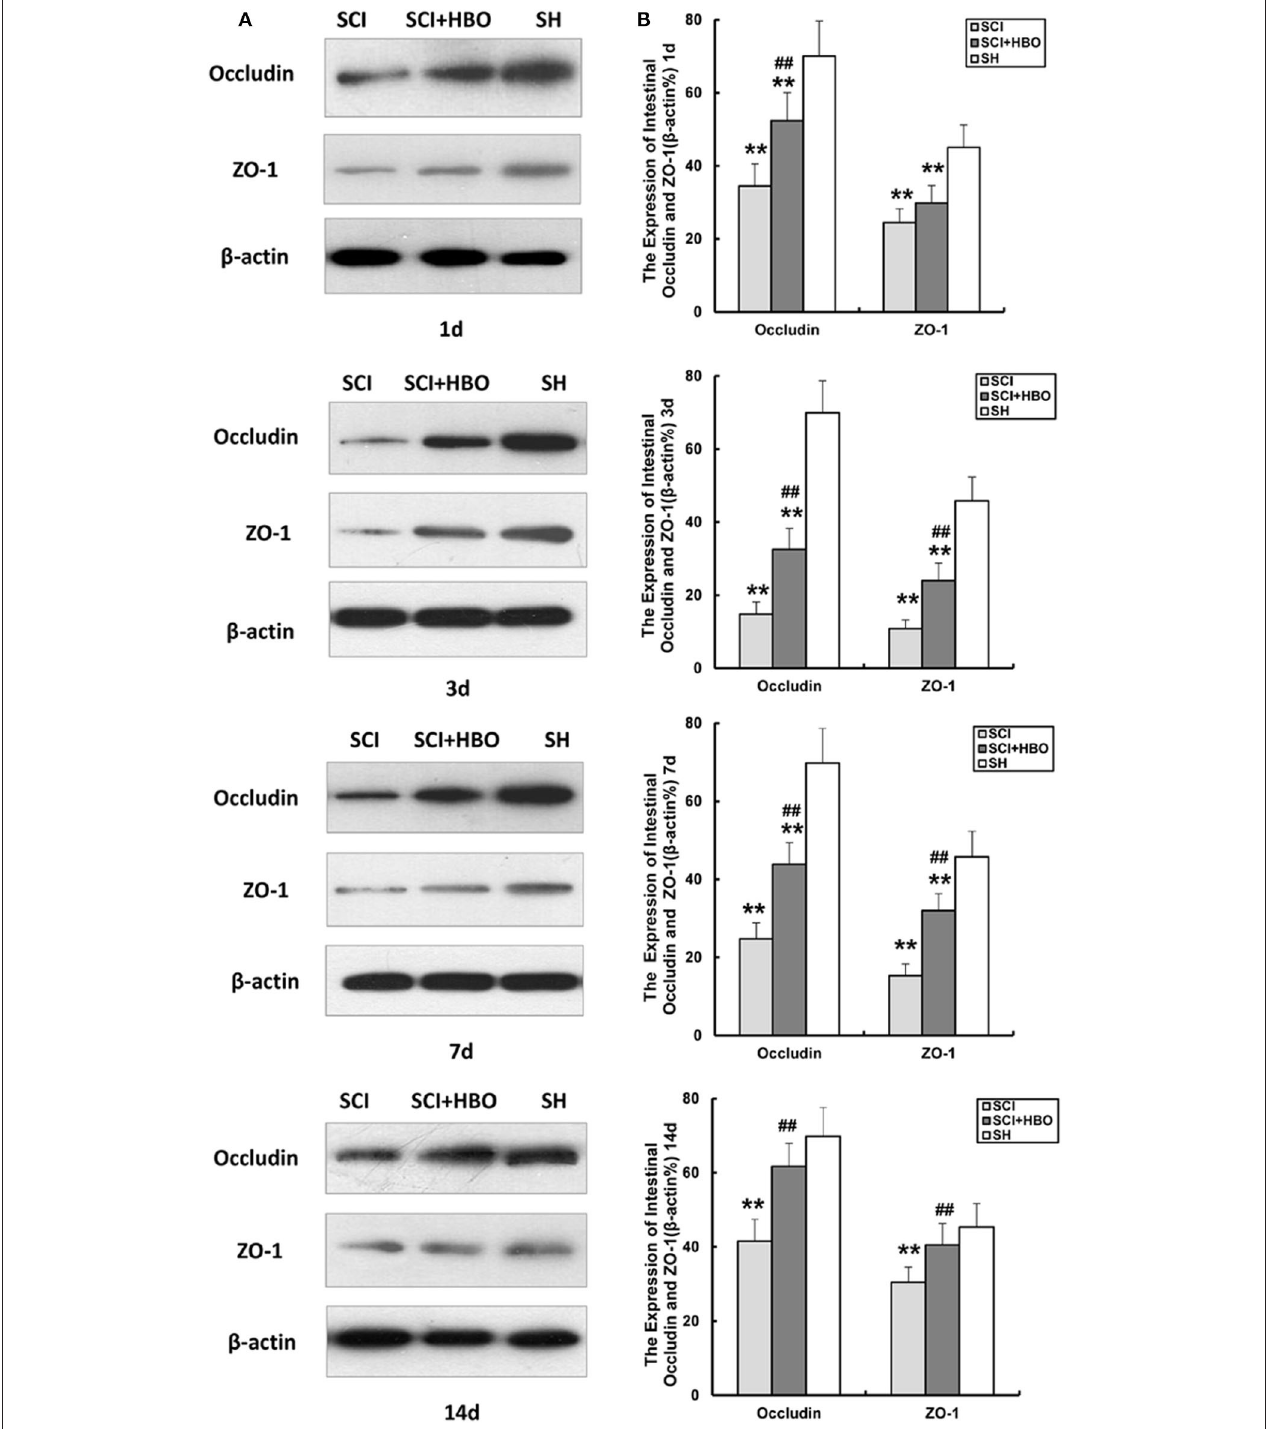
FIGURE 4 | Effect of HBO on occludin and ZO-1 protein expression in jejunum tissue after SCI. (A) Representative immunoblot of two factors at different time points postoperatively. (B) Analysis of two factors of protein expression. Data are presented as mean ± SD. Compared with the SH group, the protein expression of two factors significantly decreased in the SCI and SCI + HBO groups (** P < 0.01); HBO treatment significantly increased their protein expressions compared with the SCI group ( ## P < 0.01). HBO, hyperbaric oxygen; SCI, spinal cord injury; SH, sham operation.